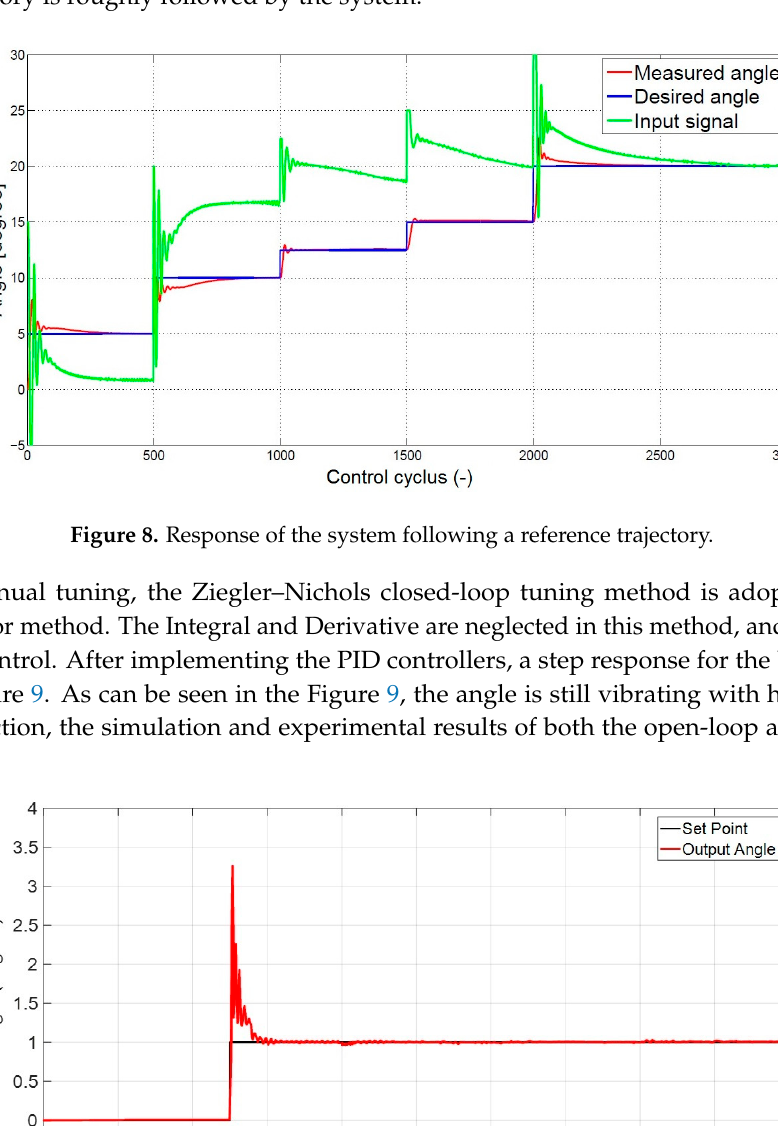
Figure 7. Control scheme to control a motor.